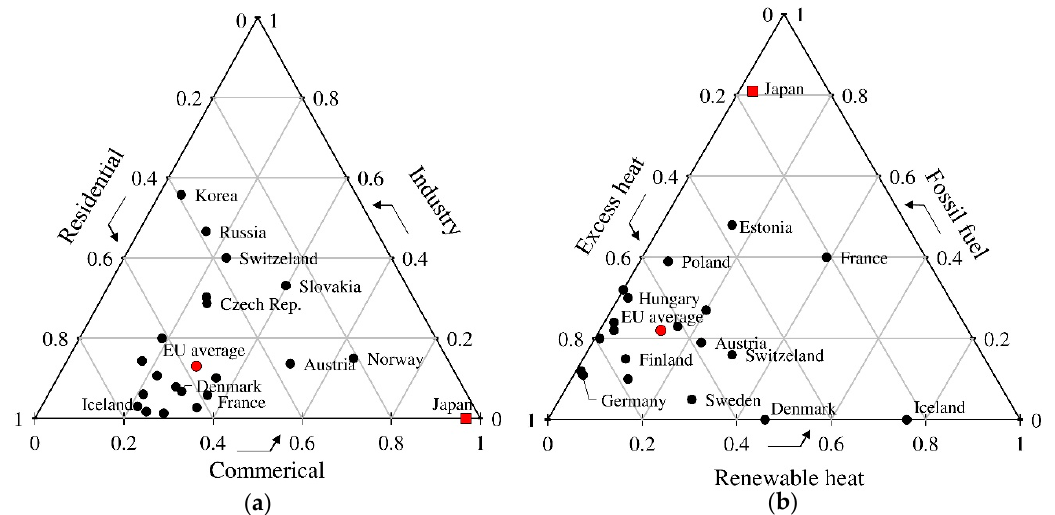
Figure 1. Demand sector and resource characteristics of DHS by country. ( a ) Demand sector. ( b ) Resource composition.